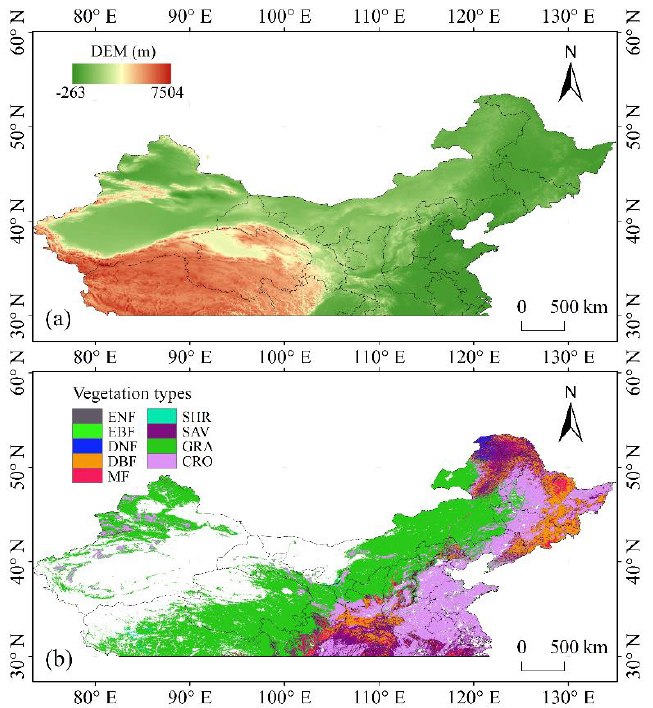
Figure 1. Spatial distribution of elevation and vegetation types in temperate regions of China. Data